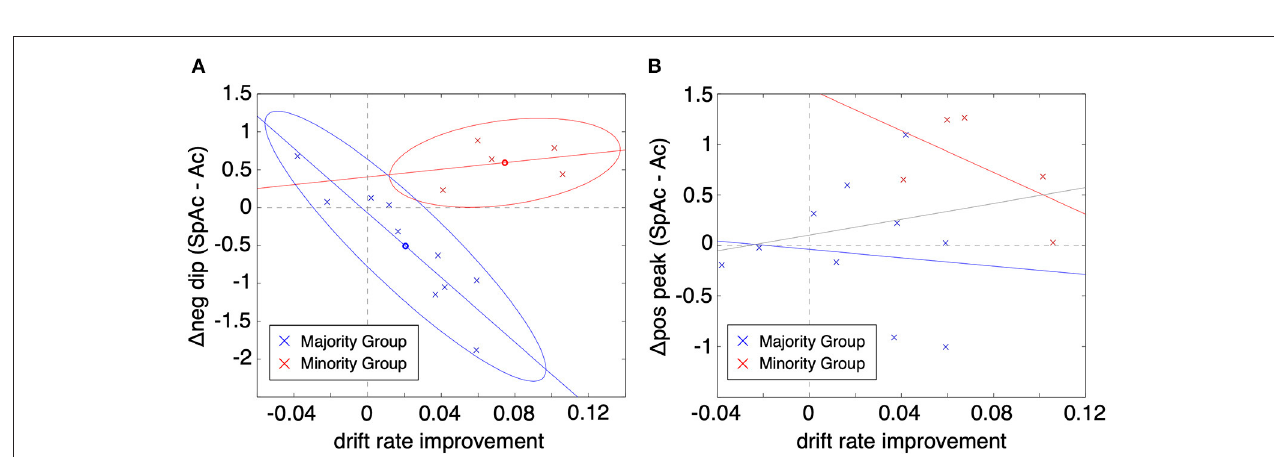
FIGURE 5 | Change in PVC BOLD response vs. improvement in drift rate (SpAc-Ac). (A) BOLD initial dip vs. drift rate improvement. Each data point represents a single subject and task difficulty (difficulty values 4 and 5 plotted). Two-cluster Gaussian mixture modeling revealed two distinct classes of responses. The majority group (10 subjects; blue x’s) exhibited significant correlation between change in PVC initial dip amplitude and drift rate improvement ( cc = − 0.74, P < 0.01 determined via permutation testing). The minority group (red x’s) exhibited significantly higher SpAc-Ac drift rate improvements [ P < 0.01, t -test (Ernst and Hennig, 1994)]. (B) BOLD positive overshoot vs. drift rate improvement. Neither group had significant correlations between the subsequent PVC positive response ( ∼ 6s post stimulus onset) and drift rate improvement (though the correlation of the minority group was marginally significant cc = − 0.62, P =